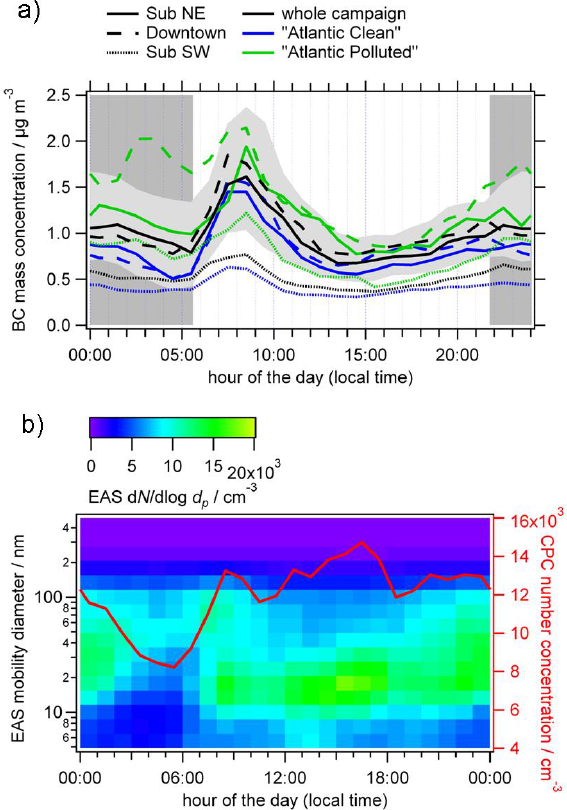
Fig. 5. (a) Diurnal cycles (hourly median values) of BC mass con- centration at the three stationary sites (for the whole campaign, and for “Atlantic Polluted” and “Atlantic Clean” air masses separately). Percentiles (25 and 75%) are shown exemplarily in light grey for the measurement at Sub NE (whole campaign); all other percentiles are omitted for clarity. The time period between sunset and sunrise is shaded in grey. (b) Diurnal cycles (hourly median values) of EAS number size distribution and CPC number concentration measured at the Sub NE